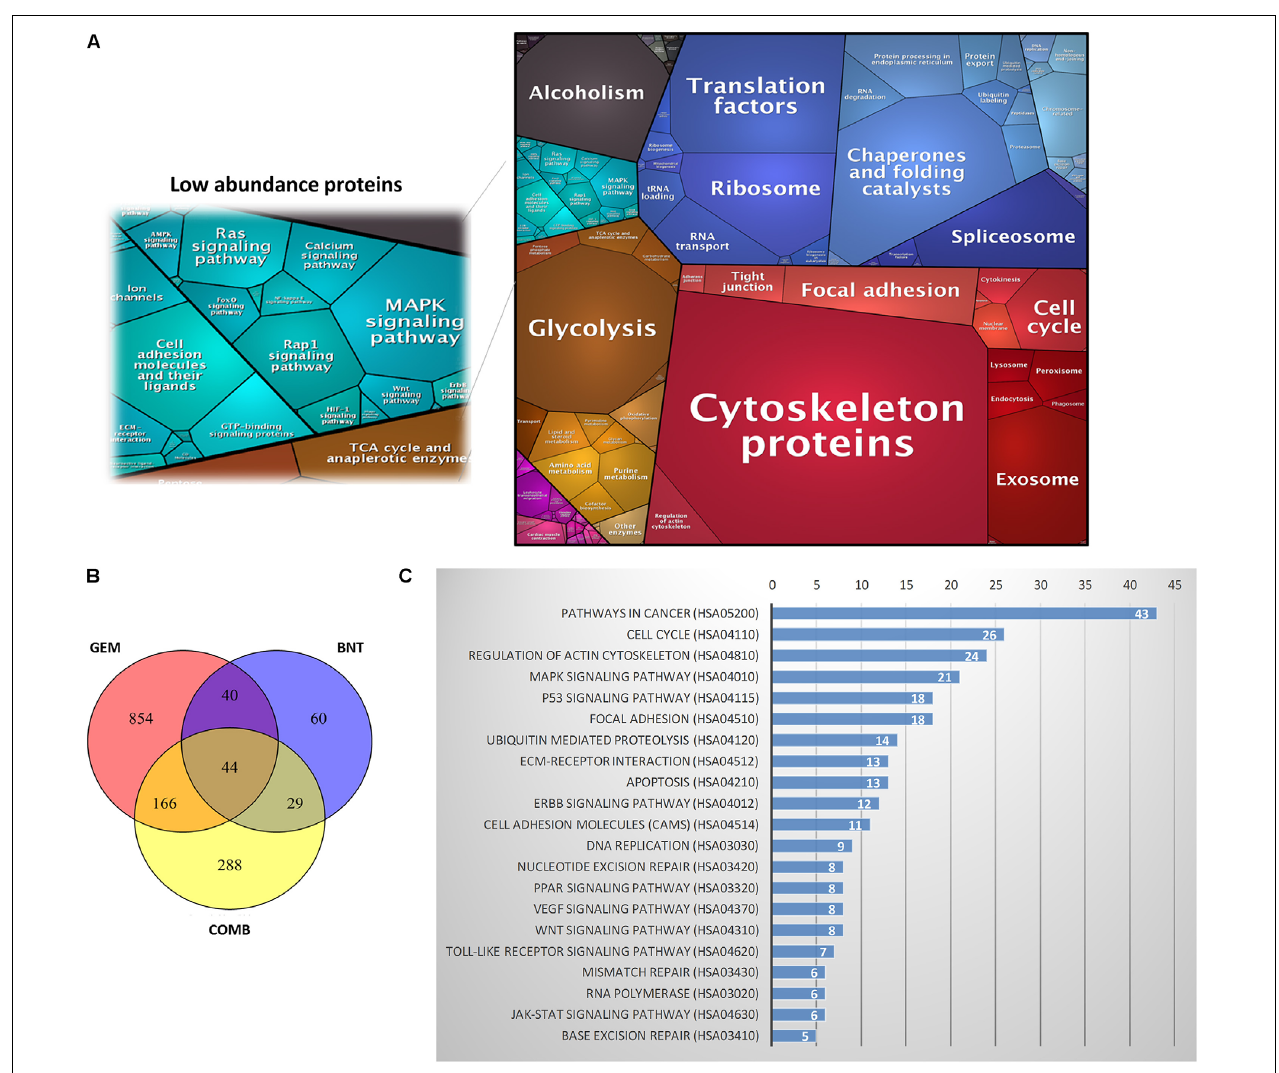
FIGURE 2 | Summary dataset generated from proteomic analysis. (A) Proteomap of the proteins identified in PANC-1 cells. (B) Distribution of the 1481 proteins that were changed significantly ( > 1.4-fold and p < 0.05) in the three treatment groups: gemcitabine (GEM), birinapant (BNT), and GEM/BNT combined (COMB). A total of 854 proteins were changed only by GEM, 60 were changed only by BNT, and 288 were changed only by the combination (COMB group). Forty-four proteins were changed significantly in all three groups. (C) Representative functional pathways containing the largest number of identified proteins altered by the treatments; the number of proteins identified in each pathway is shown in each